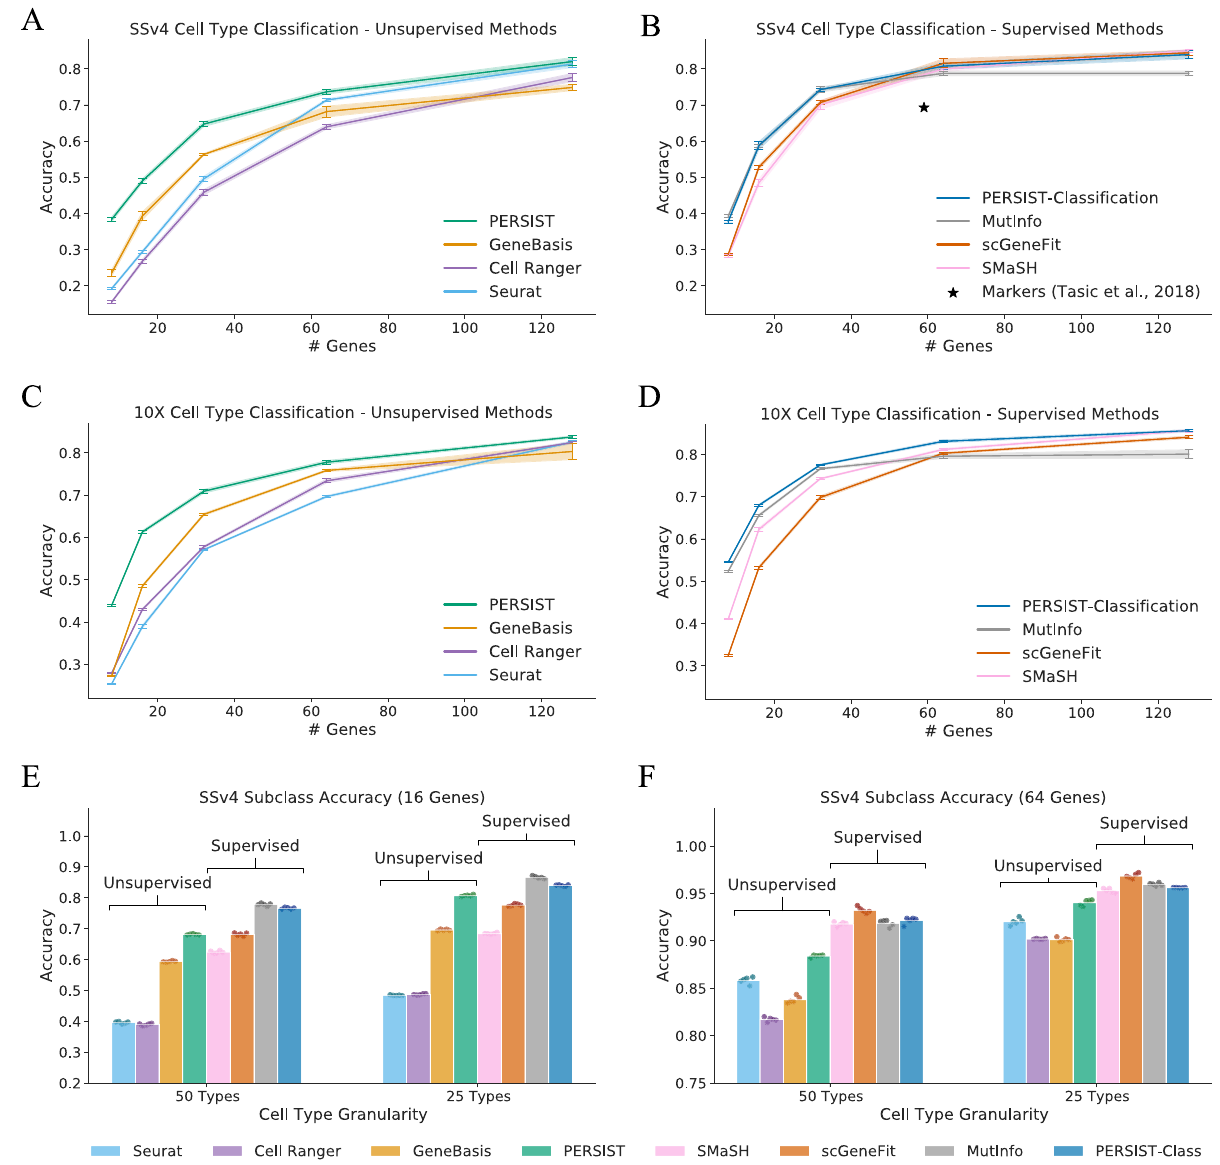
Fig. 3 | Evaluating gene panels based on their ability to classify cell types. The selected genes are used to classify scRNA-seq cell types, and PERSIST achieves strongperformancedespitenotusingcelltypelabelsduring theselectionprocess. PERSIST-Classi fi cation, a version modi fi ed to distinguish cell types, matches the best existing supervised approaches. A Cell type classi fi cation accuracy for gene panels selected by unsupervised methods with the SSv4 dataset (higher is better). B Accuracyfor gene panels selected bysupervised methods withthe SSv4 dataset. C Accuracy for unsupervised methods with the 10X dataset. D Accuracy for